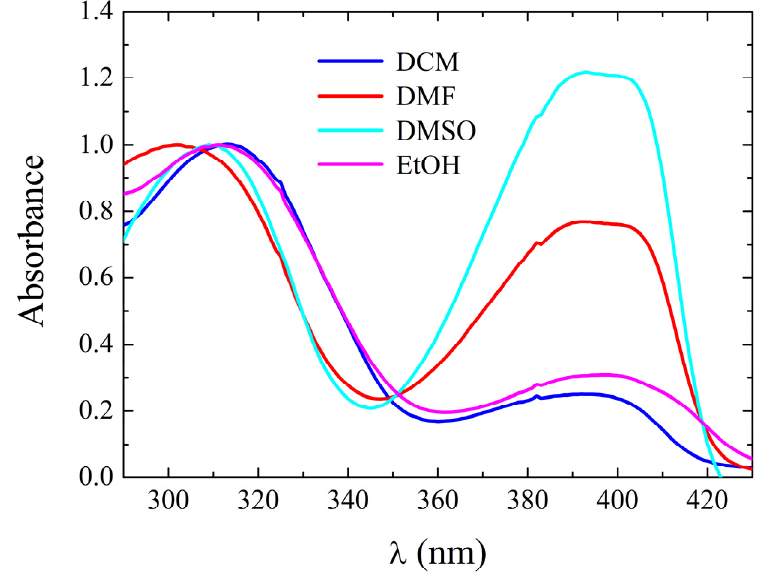
Figure 2. Absorption spectra of 1 in selected solvents.